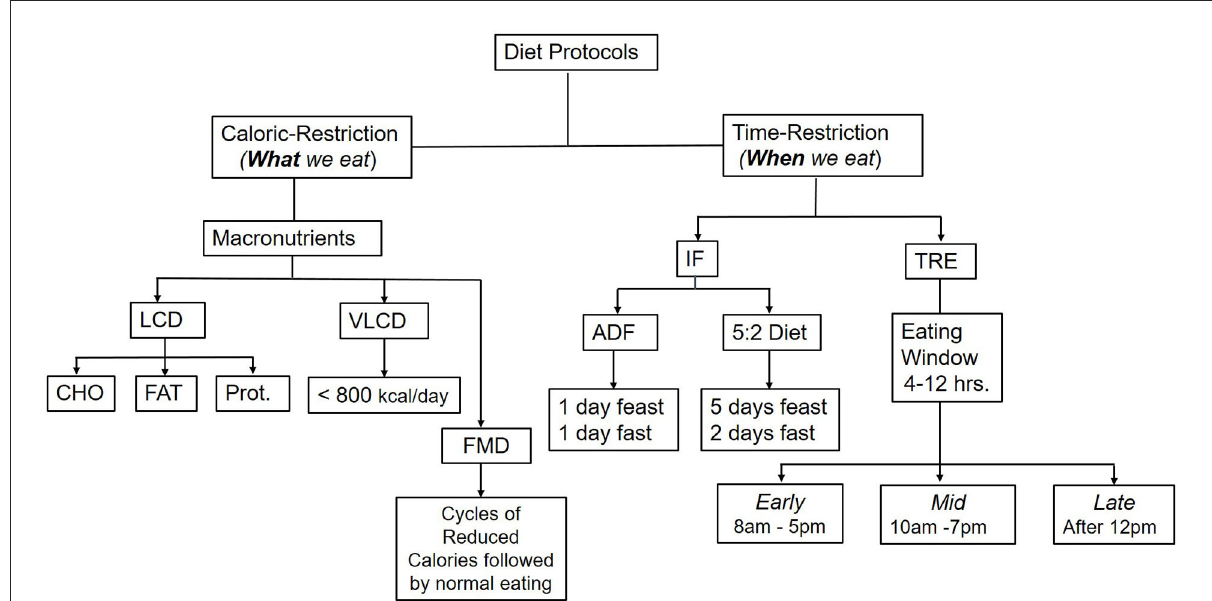
FIGURE1 Common caloric-restriction and time-restriction diet protocols. Comprehensive weight management programs include a low-calorie diet (LCD), physical activity and behavior modifications. In addition, pharmacological drugs or weight loss (bariatric surgery) may be added if co-morbidities exist or at a certain high BMI. LCD could be either a low carbohydrate (CHO) diet, low fat (FAT), or under specific circumstances, low protein (Prot.). A very low-calorie diet (VLCD), which provides only 800 kcal/day, is used only with medical supervision. Time-restricted diets include Intermittent fasting (IF), Time-restricted eating (TRE), and Fasting-mimicking diets (FMN). TRE could be either at the earlier part of the day, starting from 8 AM to 5 PM, or midday with delayed breakfast from 10 AM to 7 PM, or late from 12 PM − 8 PM or a variation of these times as a personal